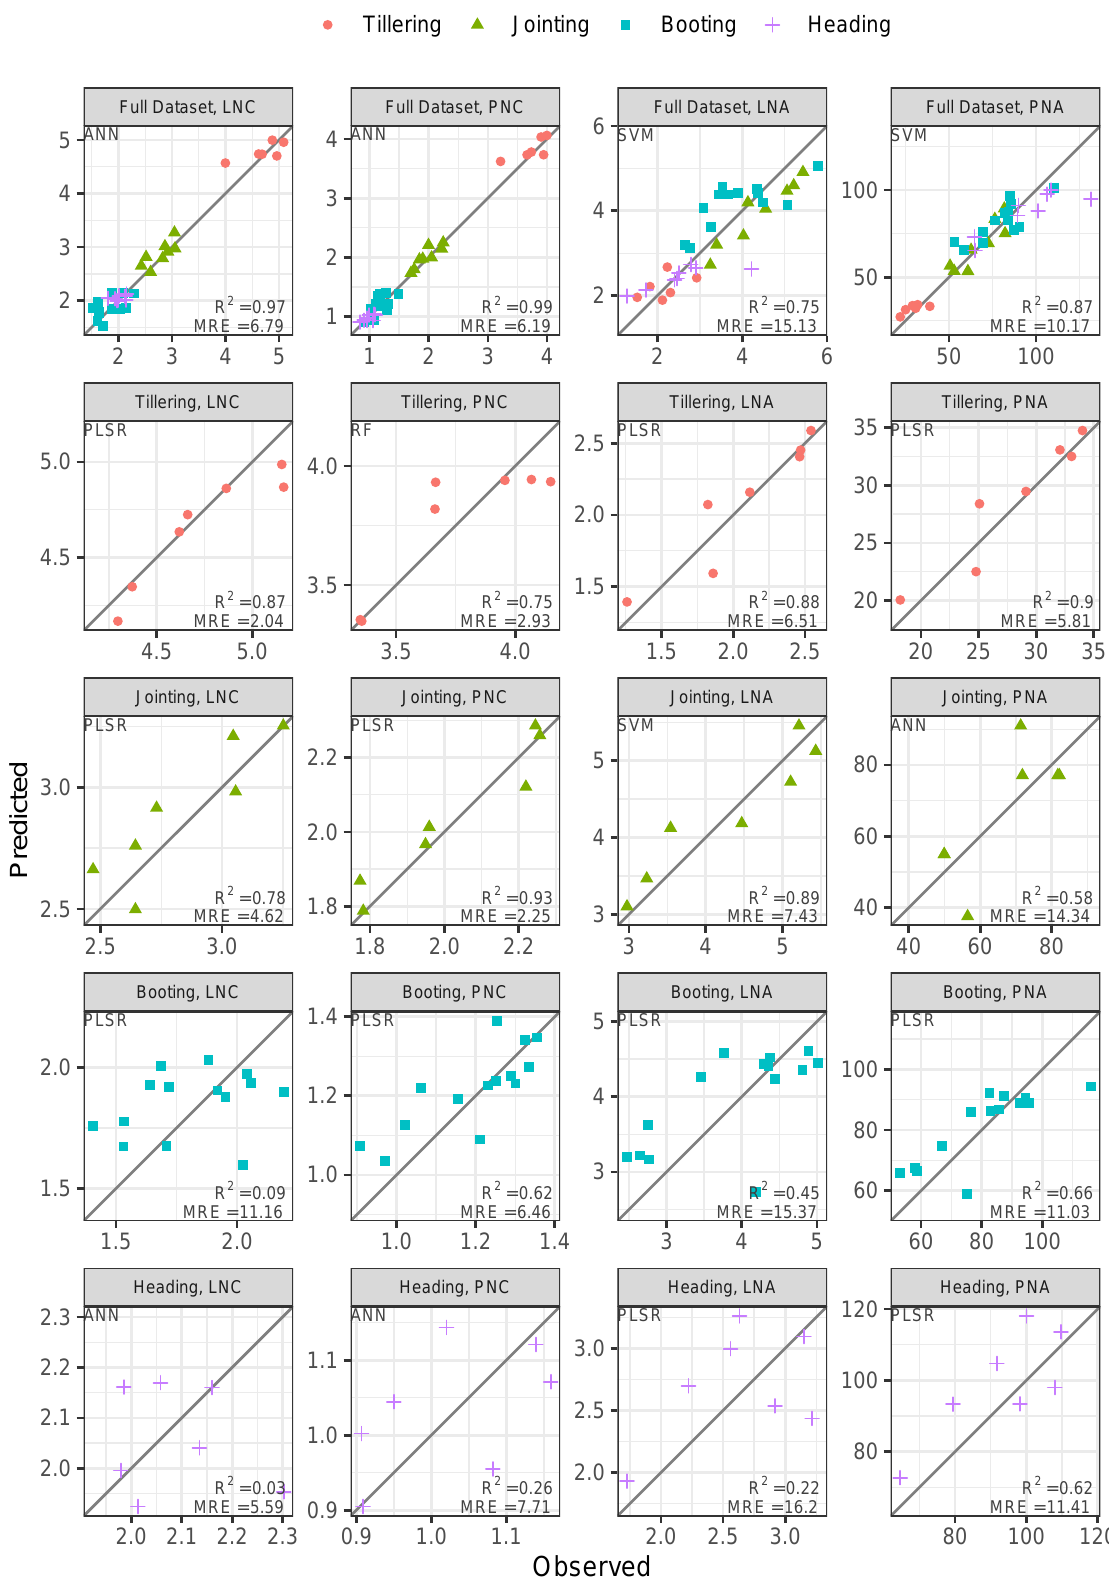
Figure 7. Scatter plots between observed and predicted nitrogen traits in the validation data set of the models listed